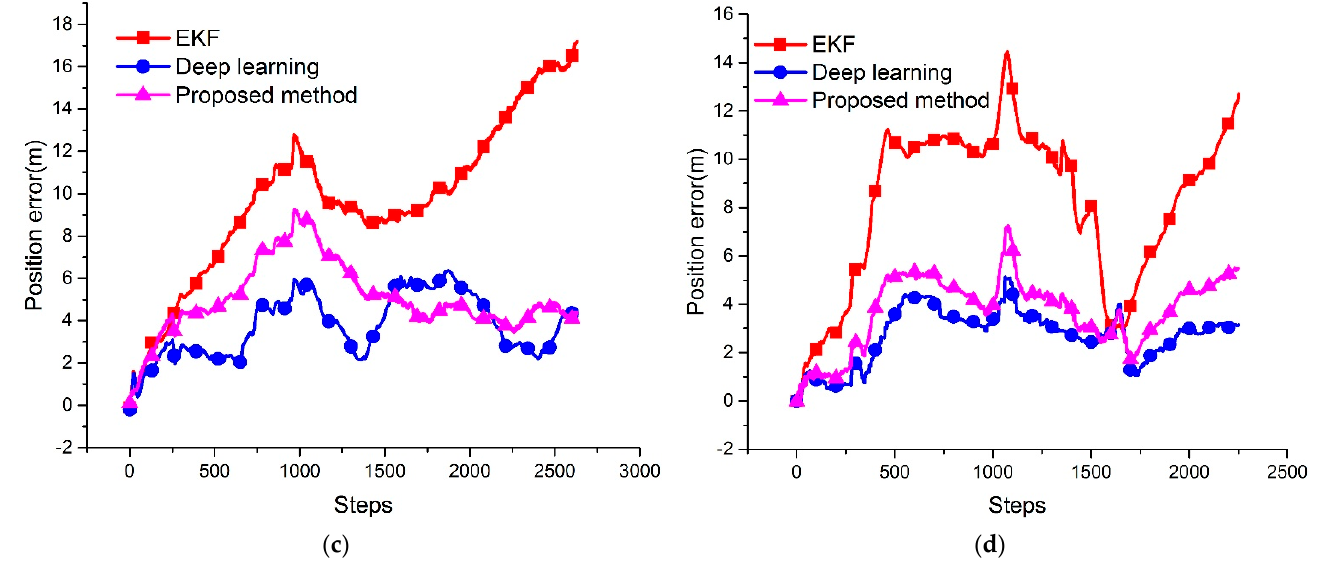
Figure 7. Position error between the ground truth and the estimation of different navigation methods. Table 7. Root mean square error (RMSE) of position in different navigation methods.